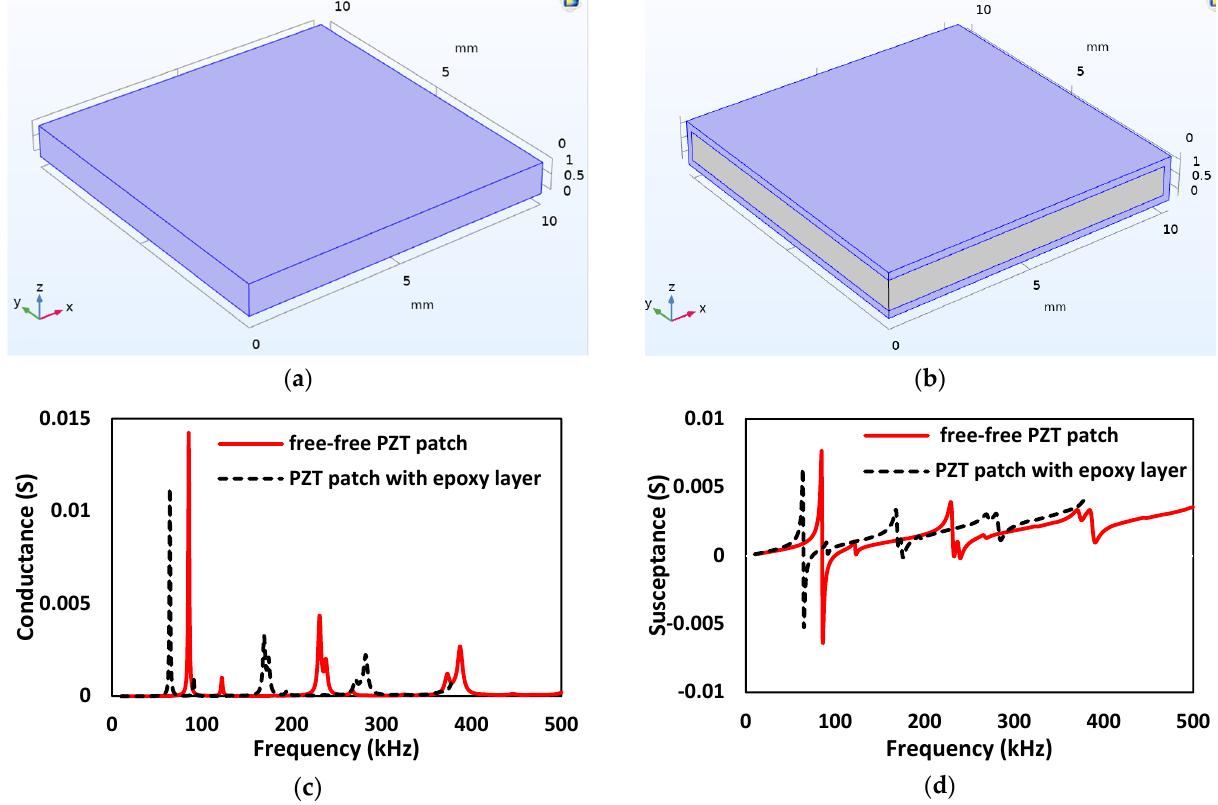
Figure 6. Representation of two-axis symmetry 3D model of ( a ) free-free PZT patch; ( b ) PZT patch with epoxy layer; ( c ) conductance and ( d ) susceptance plot based on the EMI measurement. Table 3. Properties of concrete.